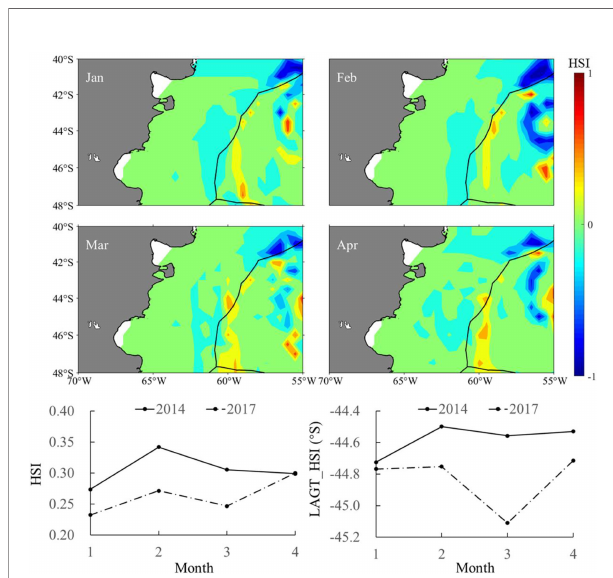
FIGURE 10 | Spatial and temporal difference in habitat suitability index (HSI) (the upper panel) and average HSI and latitudinal gravity centers of HSI (LATG_HSI) (lower panel) from January to April between 2014 and 2017 in the Southwest Atlantic Ocean.